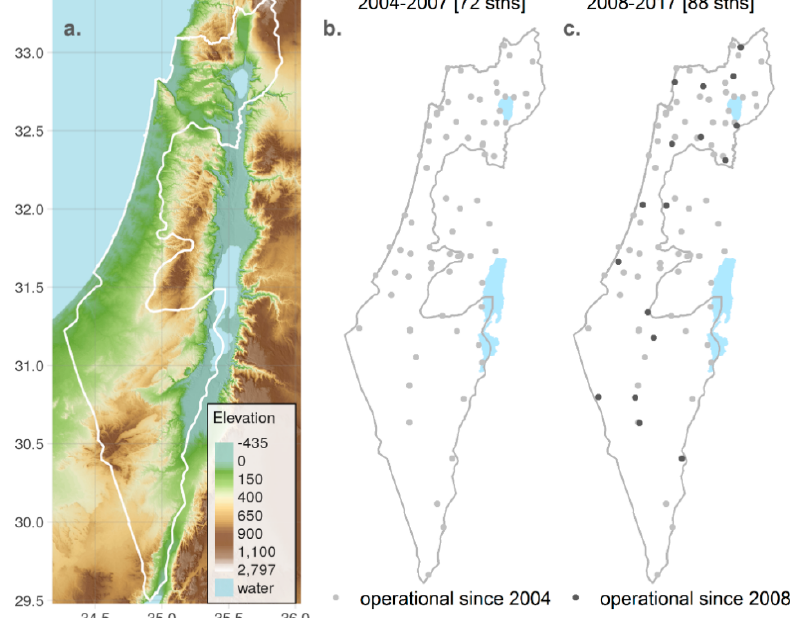
Figure 1. Topography of Israel ( a ) and the location of weather stations of the Israel Meteorological Service (IMS) employed in this study ( b , c ).